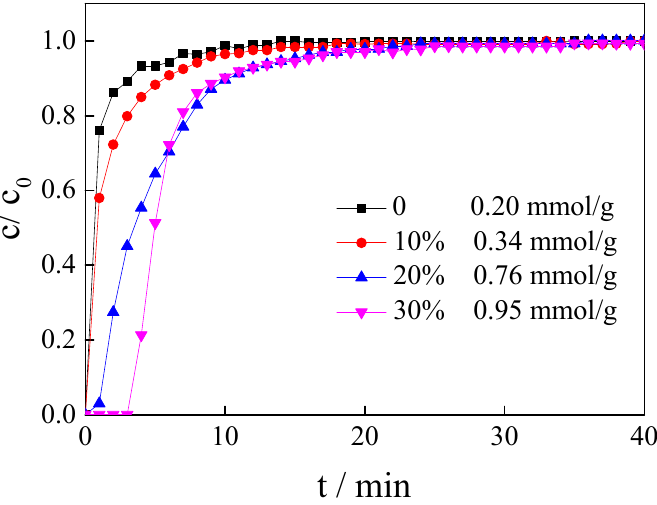
Figure 5. The CO 2 adsorption curves and CO 2 capacity of magnesite modified by [APMIM]Br with different loading amounts (3 g, 100 mL/min flow rate, 50 ◦ C and 0 MPa).